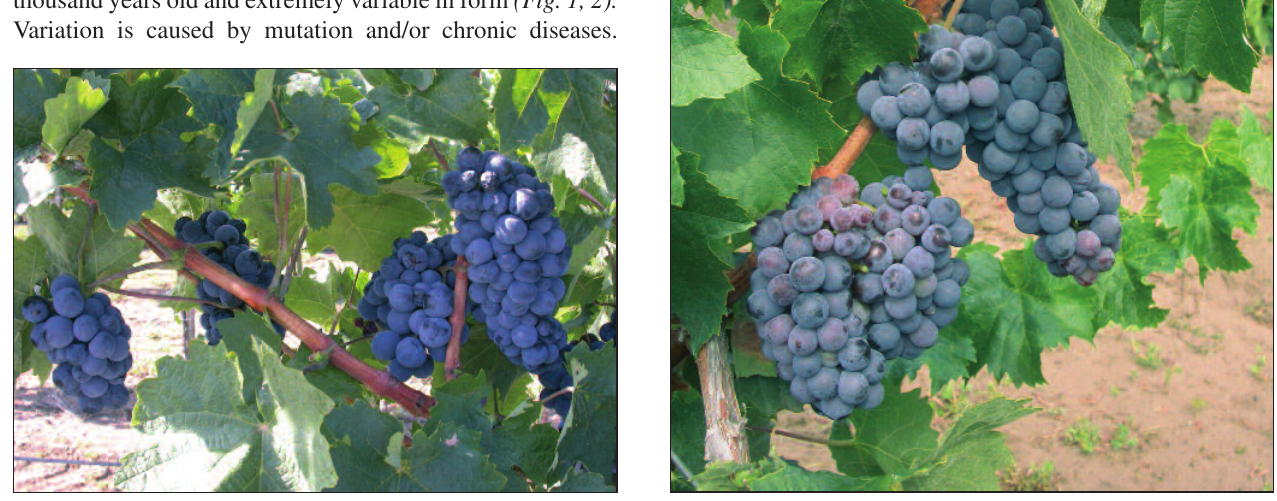
Fig. 1. Kadarka with little grapes and bigger berries Fig. 2. Kadarka with bigger grapes and little